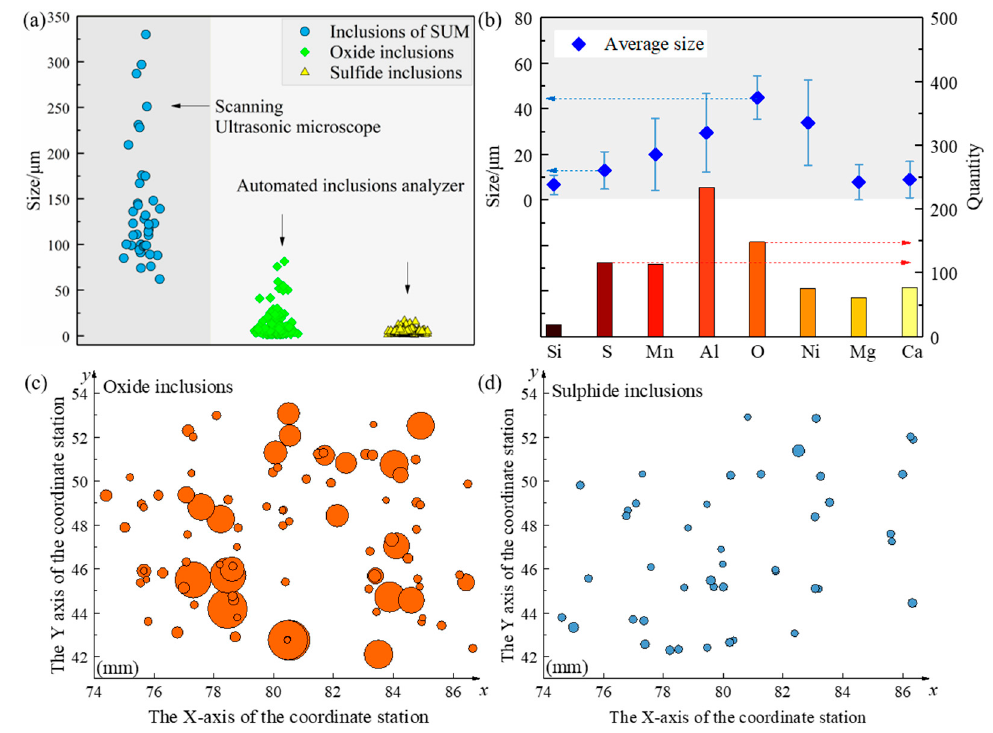
Figure 10. The comparison of inclusions size between automatic inclusions analysis and scanning ultrasound microscopy (SUM) analysis ( a ) and the average size and quantity in different inclusions statistics ( b ), and the planar distribution ( c , d ) of inclusions with different compositions were also made.